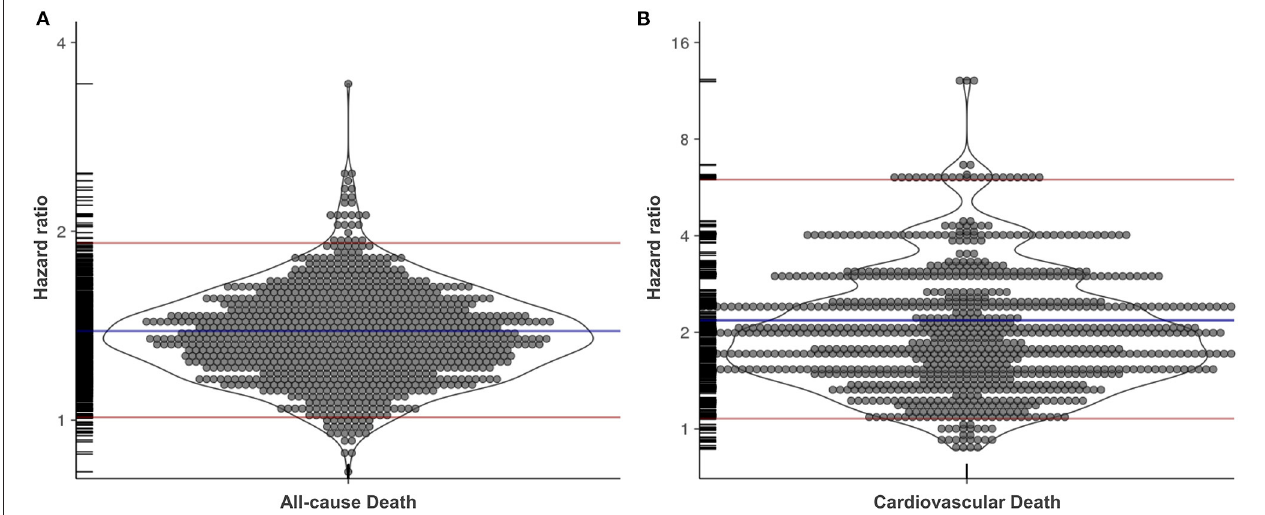
FIGURE 3 | The hazard ratio of transient albuminuria on all-cause death and cardiovascular death after bootstrapping with propensity score matching. Each circle represents a hazard ratio for all-cause death (A) and cardiovascular death (B) . Blue lines and red lines represent mean and 95% confidence intervals, respectively. Rug plot for data is displayed along the